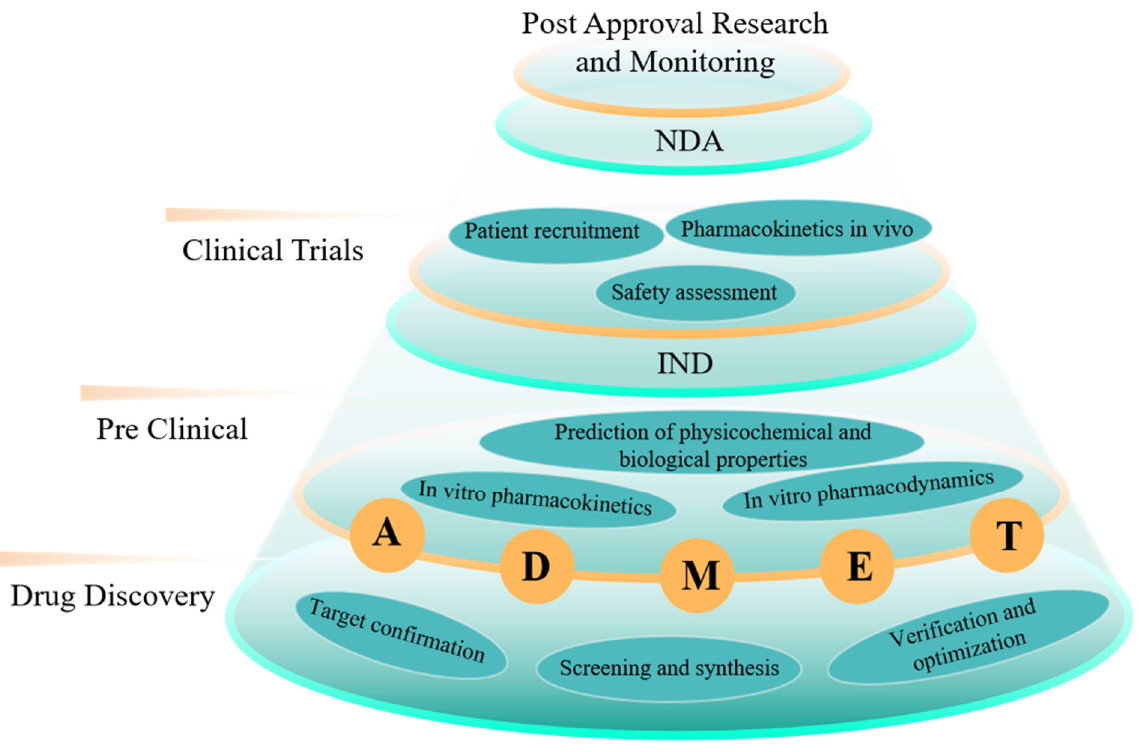
Figure 1. A brief introduction to research and development process of nanodrugs and applications in computing. in